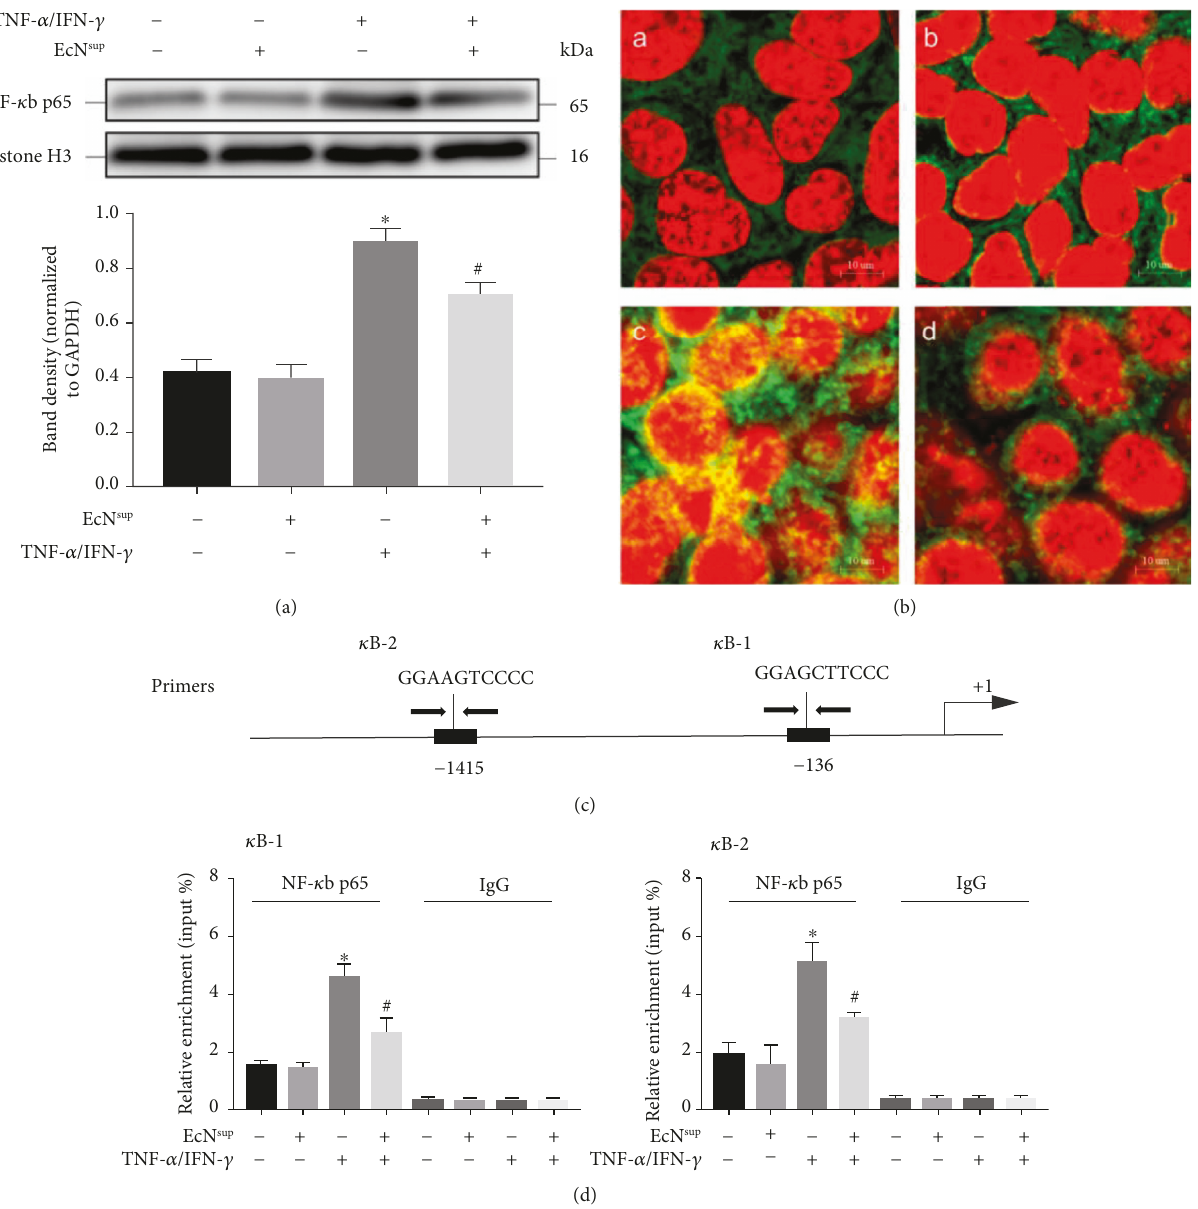
Figure 6: EcN sup suppressed the activation of NF- κ B. (a) The nuclear protein of monolayers was harvested after incubation for 48h in the absence or presence of 10ng/mL TNF- α and 10 ng/mL IFN- γ with or without 100 ng/mL EcN sup followed by western blot assays. (b) Caco-2 monolayers were stained for NF- κ B p65 by immuno fl uorescence. Cotreatment with 100ng/mL EcN sup signi fi cantly inhibited the nuclear translocation of NF- κ B p65 elicited by TNF- α /IFN- γ . A: The control group; B: Caco-2 monolayers were exposed to 100 ng/mL EcN sup for 30min; C: Caco-2 monolayers were incubated with 10 ng/mL TNF- α and 10ng/mL IFN- γ for 30min; and D: Caco-2 monolayers were incubated with 100ng/mL EcN sup for 30min in the presence of 10ng/mL TNF- α and 10ng/mL IFN- γ . (c) Schematic illustration of human MLCK gene promoter containing two putative κ B sites ( κ B-1 and κ B-2) at -136 and -1451 as indicated. The PCR primer locations were also indicated. (d) Caco-2 cells were pretreated for 4 h with or without 100ng/mL EcN sup in the absence or presence of 10ng/mL TNF- α and 10ng/mL IFN- γ . ChIP assays were performed with anti-p65 antibodies or IgG. The results for κ B-1 and κ B-2 sites are shown. Similar results were seen for 10h treatment. Results were expressed as the mean ± SEM ( n = 3 ). ∗ P < 0 05 vs. control. # P < 0 05 vs. TNF- α /IFN- γ